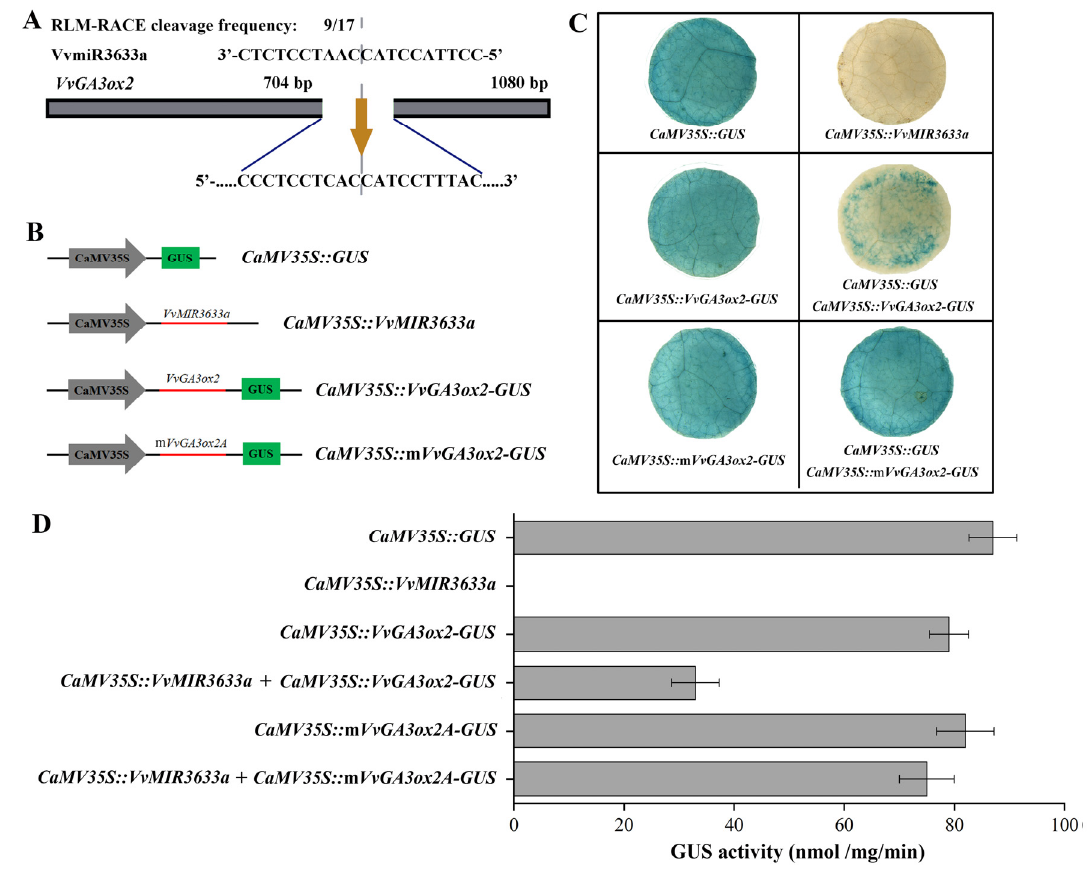
Figure 5. Validation of target genes cleavage by VvmiR3633a. The cleavage of VvGA3ox2 by VvmiR3633a was verified by the RLM-RACE technique ( A ) and tobacco transient expression tech- nique ( B , C ); GUS activity ( D